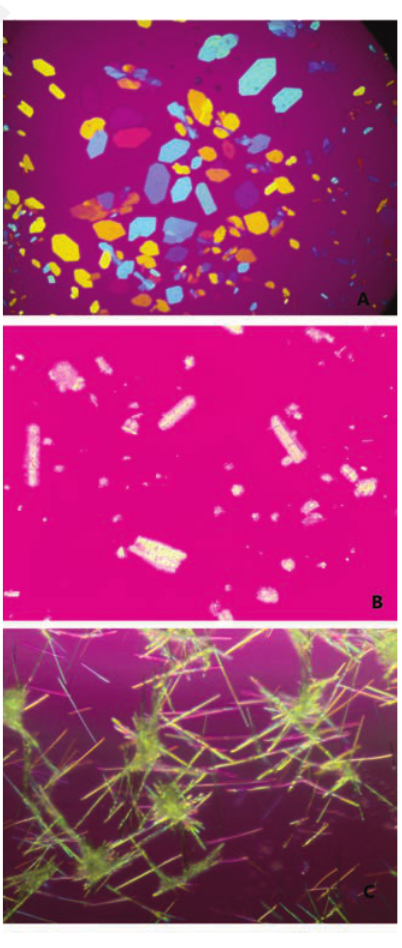
Figure 2. Photomicroscopes of cold con- tact method, (A) AS in methanol; (B) AQ in methanol; (C) AS-AQ binary mixture in